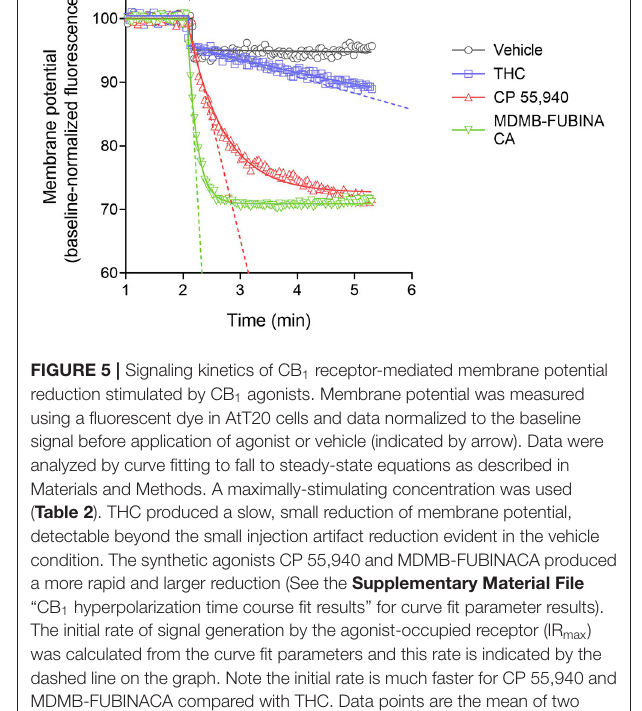
TABLE 2 | THC and SRCA signal generation rate via the CB 1 receptor.